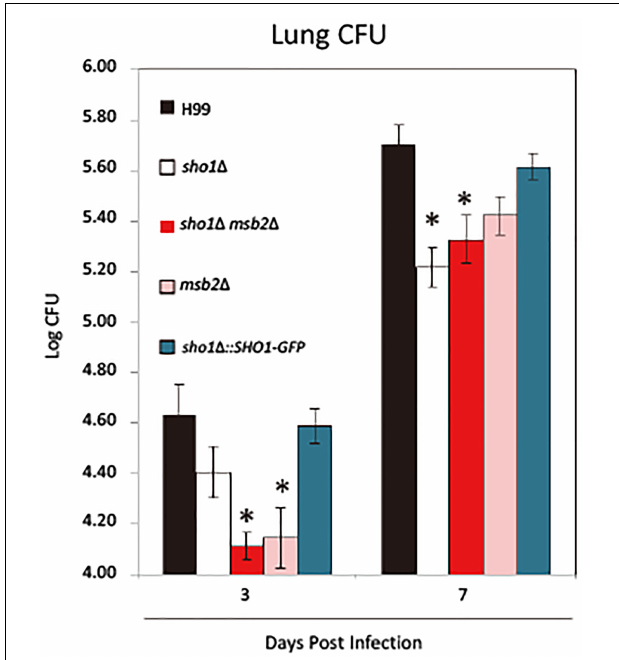
FIGURE 9 | Sho1 and Msb2 contribute to the fungal virulence during C. neoformans infection. Mice were infected intratracheally with 10 4 cells of wild-type (WT; H99), sho1 (cid:49) (YSB1719), msb2 (cid:49) (YSB3191), sho1 (cid:49) msb2 (cid:49) (YSB3605), and sho1 (cid:49) :: SHO1-GFP (YSB2753) strains of C. neoformans . Infected lungs were harvested and homogenized for the fungal burden evaluation at 3 and 7 dpi. Significant differences between fungal burdens in the lungs infected with sho1 (cid:49) , msb2 (cid:49) , and sho1 (cid:49) msb2 (cid:49) versus wild-type strains were found at 3 and (or) 7 dpi. Experiments were repeated independently with similar results ( N = 6/experimental group or above. ∗ P < 0.05 post-adjustment for multiple